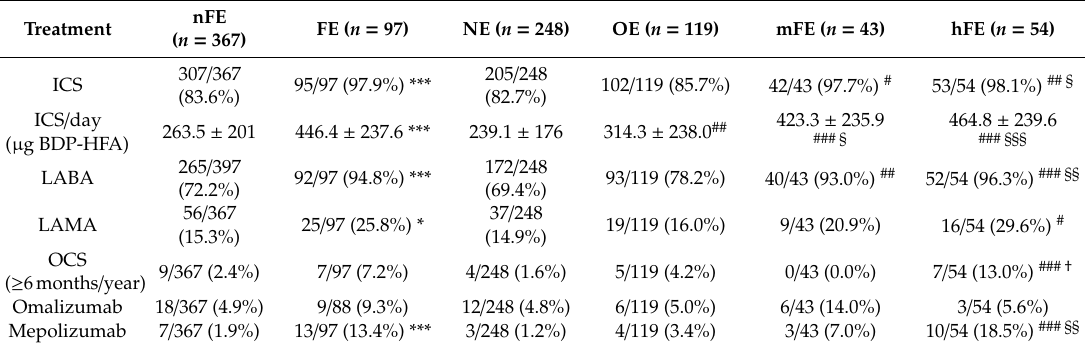
Table 3. Pharmacological treatments in the asthmatic